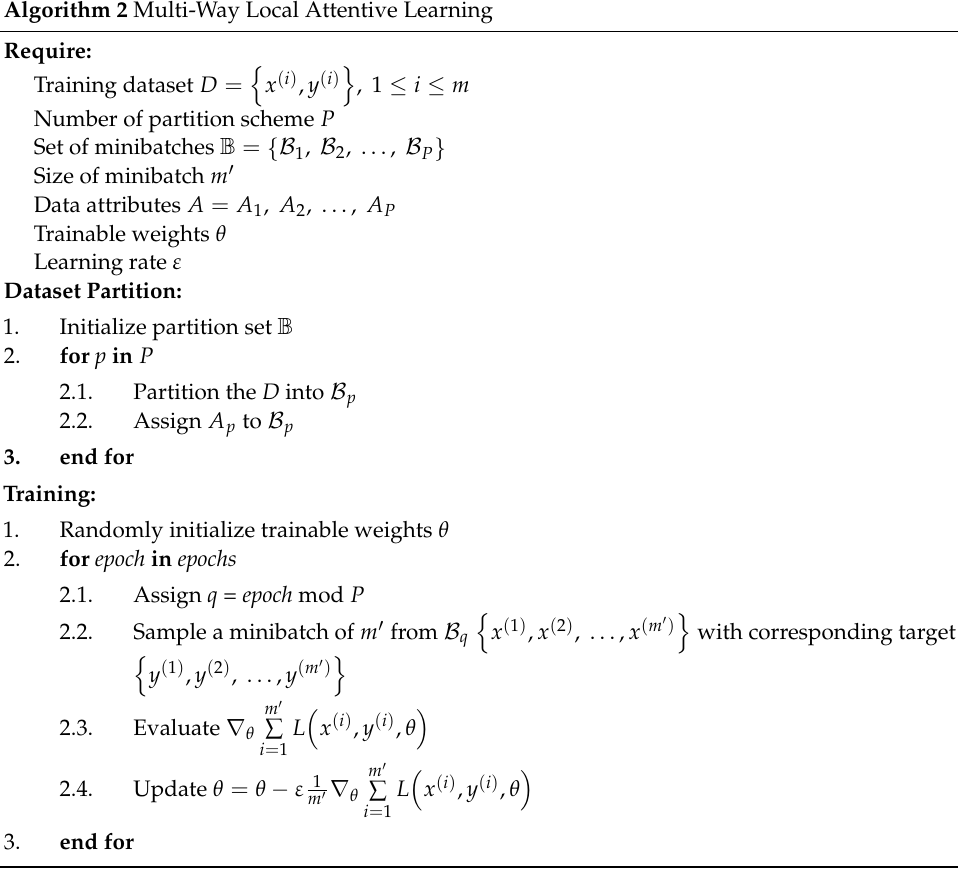
Algorithm 2 Multi-Way Local Attentive